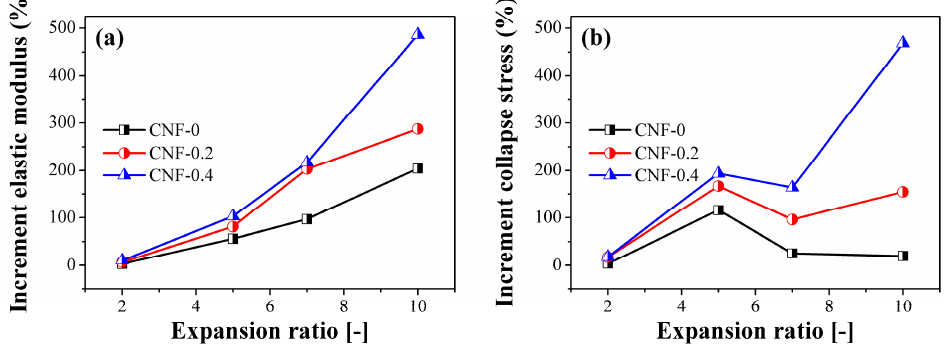
Figure 11. Percentage increment in mechanical response for the PP/CNF nanocomposite foams: ( a ) increments in elastic modulus, and ( b ) increments in collapse stress as a function of the expansion ratio.